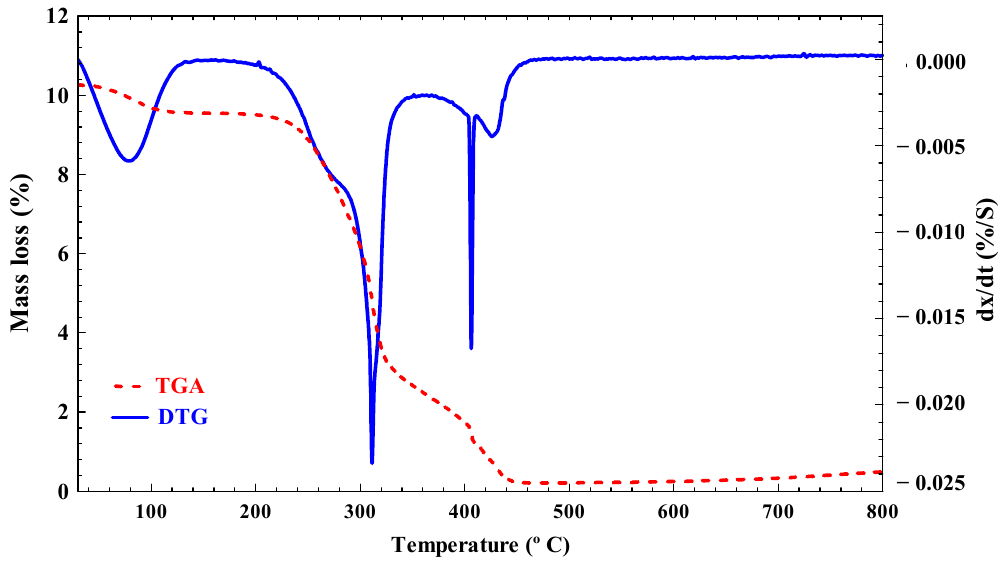
Figure 3. TGA/DTG for wheat straw sample.